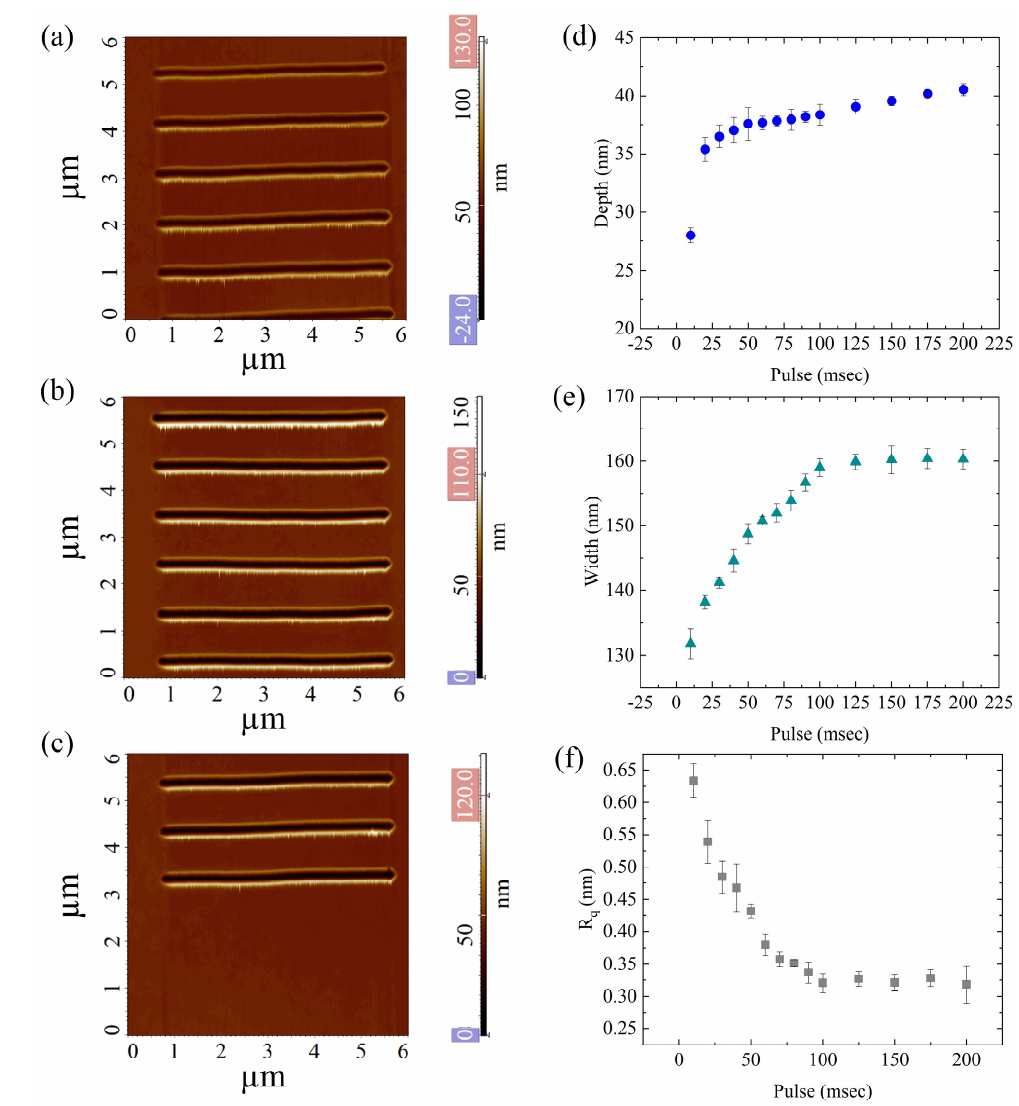
Figure 5. ( a – c ) SensHeight AFM topographic images of nanochannels patterned with an increasing pulse width value (from 10 msec to 200 msec); ( d – f ) report the variation of the mean depth, width, and roughness of nanochannels patterned with increasing pulse width values. The d, w, and R q values were reported as mean value, obtained by averaging their values at twenty-five different locations, randomly chosen from the AFM acquisitions. The pink and blue boxes in Figure 5a–c represent the minimum and maximum adjustment of the colour scale. The data reported in ( d , e ) are statistically significant for p < 0.001 while the data in ( f ) are statistically significant for p < 0.05.